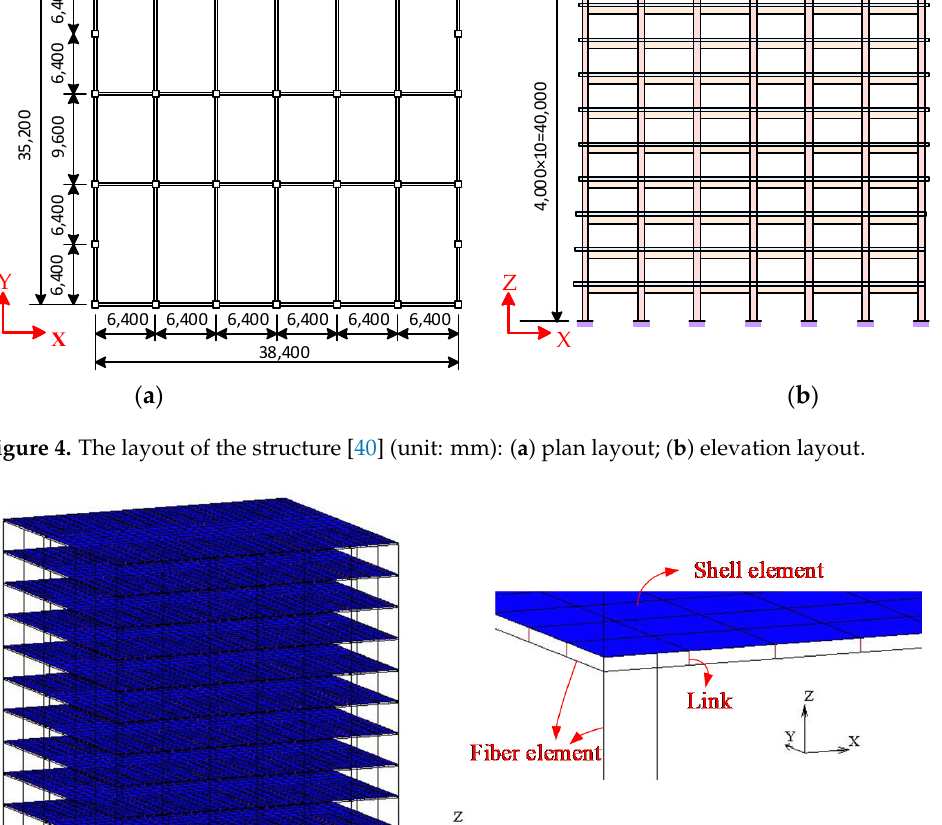
Figure 3. The validation of the FE model with test results: ( a ) test photo of the composite frame with URSP connectors [37]; ( b ) FE model of the test specimen; ( c ) comparison of test and FE model load– displacement curves.